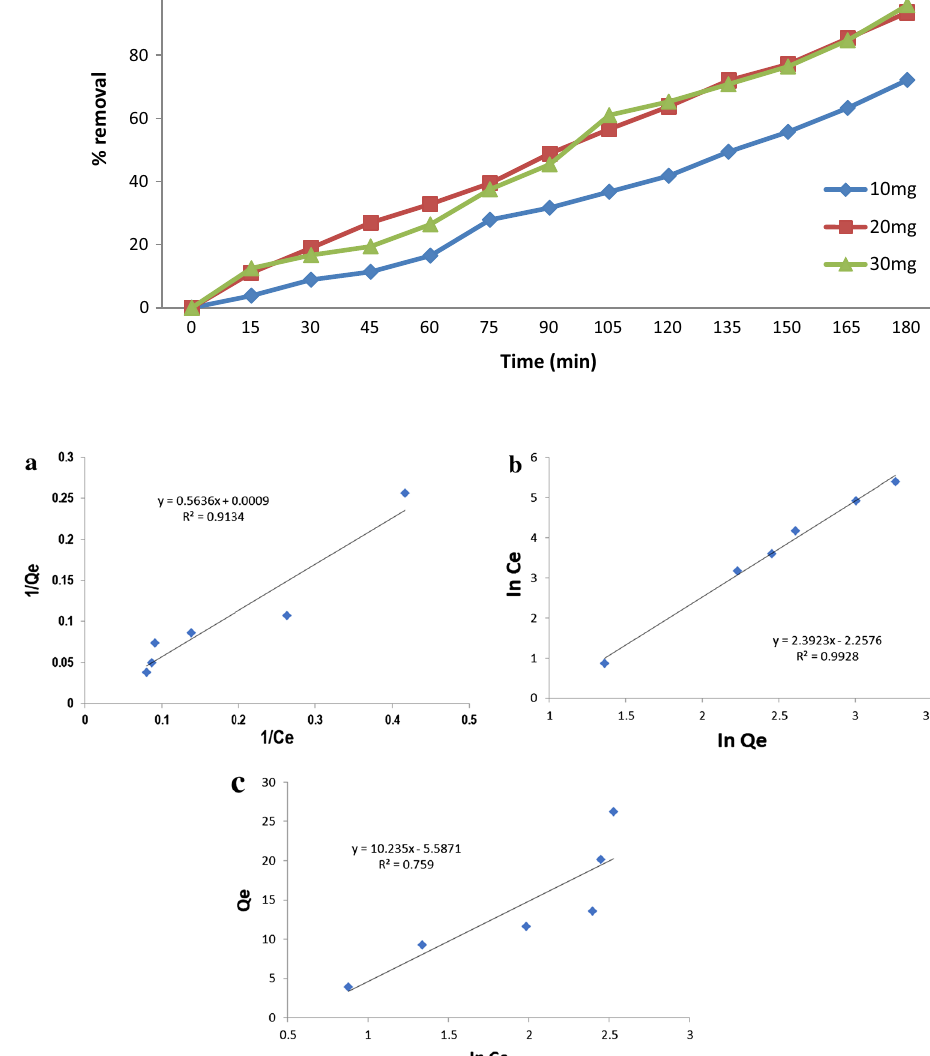
Fig. 8 Percentage chromium removal efficiency of chitosan- coated SPIONs at regular intervals of time